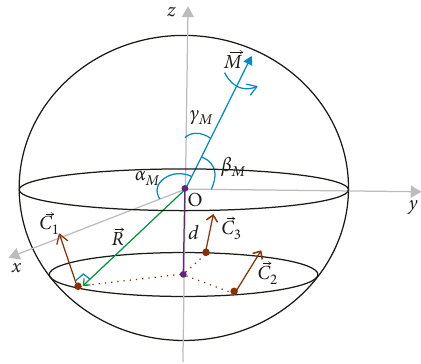
Figure 7: Schematic drawing of the rotating